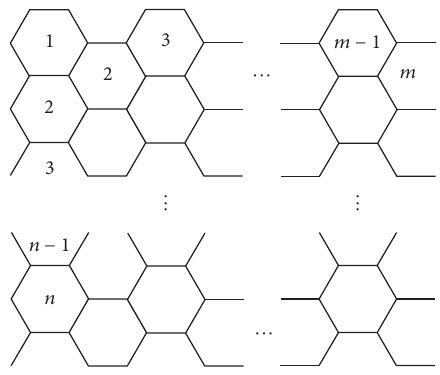
Figure 4: The 3D lattice of the armchair TUAC 6 [𝑚,𝑛]